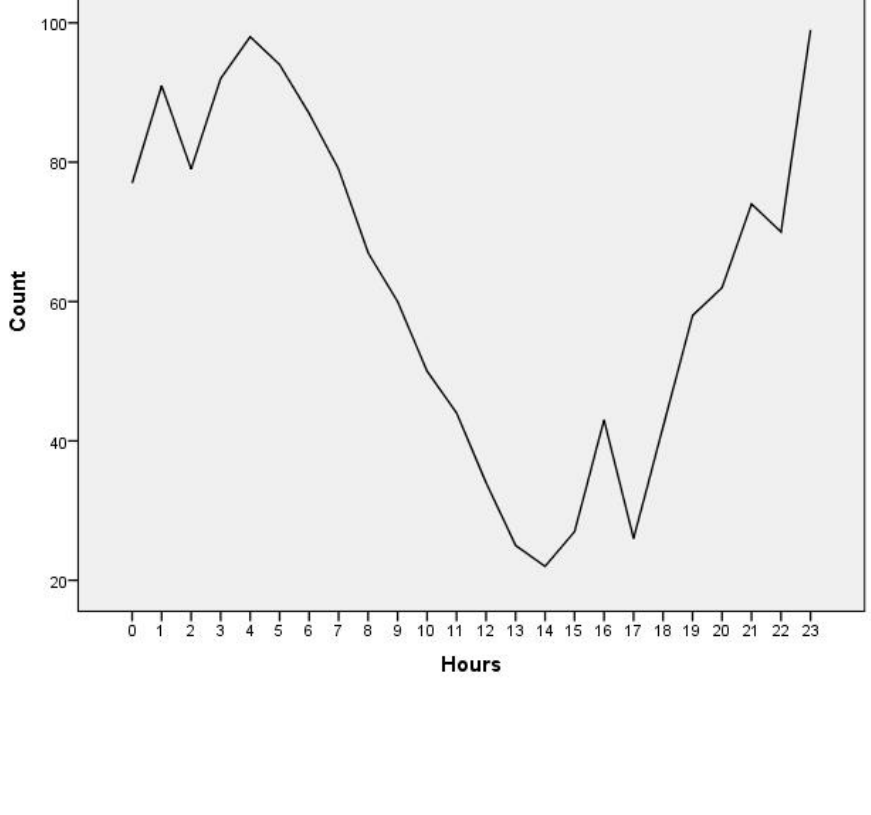
Figure 1. Hourly distribution of all 1500 tweets during the day from hour 0 (00:00-00:59) to hour 23 (23:00-23:59) Coordinated Universal Time